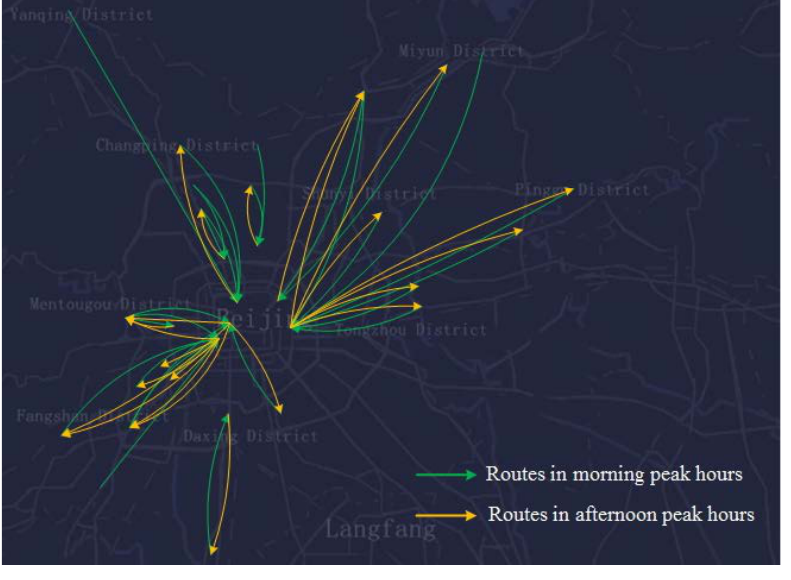
Figure 10. Potential CB routes between outer suburban and urban areas.